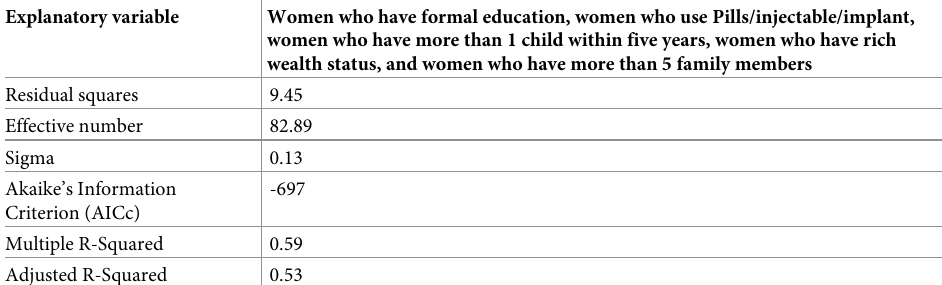
Table 6. Geographically weighted regression (GWR) model for anemia among WRA delivery in Ethiopia, EDHS 2016.